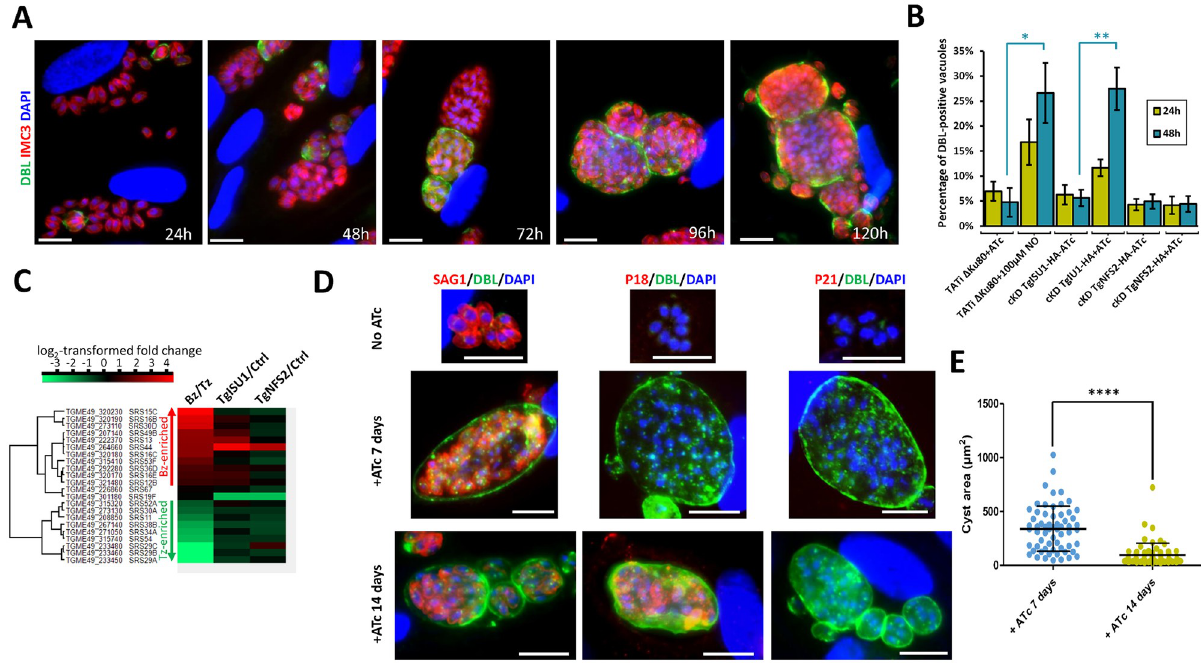
Fig 9. Depletion of TgISU1 triggers parasite differentiation. A) cKD TgISU1-HA parasites were grown in the presence of ATc and labelled with anti- TgIMC3 (to outline parasites) and a lectin of Dolicos biflorus (DBL) to specifically outline nascent cyst walls. Scale bar represents 10 μ m. DNA was labelled with DAPI. DIC: differential interference contrast. B) Quantification of DBL-positive vacuoles after 24 hours or 48 hours of culture of 1) the cKD TgISU1-HA and cKD TgNFS2-HA mutants in the presence or absence of ATc 2) the Tati Δ Ku80 cell line, as a negative control, 3) the Tati Δ Ku80 cell line in the presence of 100 μ M nitric oxide (NO), as a positive control. Data are from n = 3 independent experiments. Values are mean ± SEM. � p � 0.05, �� p � 0.01, Student’s t -test C) Clustering of bradyzoite (Bz) or tachyzoite (Tz)-specific proteins of the SRS family shows specific enrichment of bradyzoite proteins upon TgISU1 depletion. D) The cKD TgISU1-HA mutant was grown for up to 14 days in the presence of ATc and co-stained with early cyst wall marker DBL together with tachyzoite marker SAG1, or intermediate (P18/SAG4), or late (P21) bradyzoite markers. Scale bar represents 10 μ m. DNA was labelled with DAPI. E) Measurement of the cyst area size after growing the cKD TgISU1-HA mutant for 7 and 14 days in the presence of ATc and labelling the cyst wall with DBL and measuring the surface of 60 cysts per condition. Mean ± SD is represented. One representative experiment out of three independent biological replicates is shown. ���� denotes p � 0.0001, Student’s t -test.